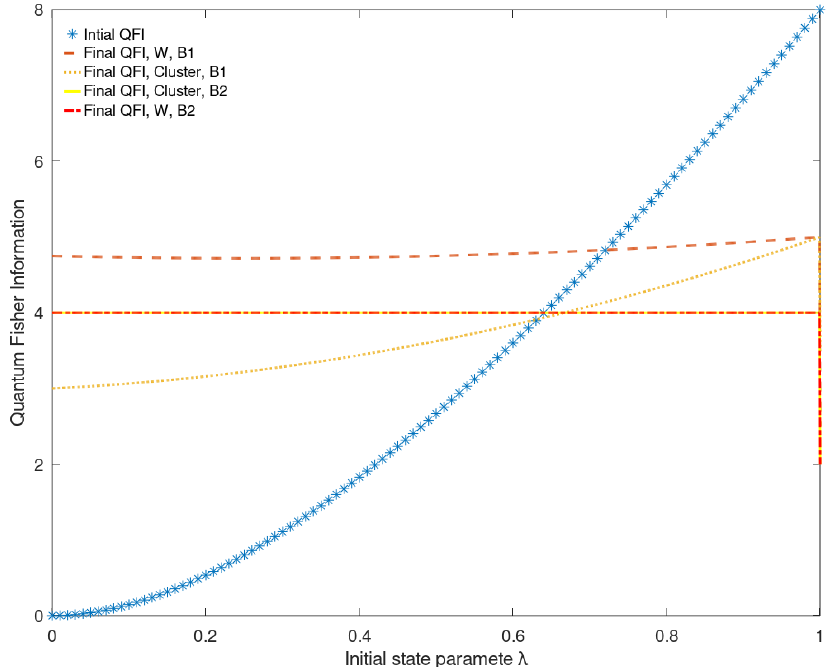
Figure 2. Comparison between the quantum Fisher information attainable by Alice’s initial state ρ A and the average over the quantum Fisher information obtained by Bob’s final states, using the 4-qubit cluster state | ψ (cid:105) , and the 4-qubit symmetric W state as a channel. The blue line marked with C ’*’s shows the variation of the quantum Fisher information as obtained by Alice’s initial state with respect to the state parameter λ . The dotted and solid yellow lines respectively depict the average quantum Fisher information obtained by Bob’s final states, when Alice measures her qubit in bases B 1 and B 2 , and the cluster state is used as a channel. The dashed and dashed-dotted red lines represent Bob’s average QFI, when the 4-qubit W state is used as a channel, and Alice’s register is measured in bases B 1 and B 2 ,